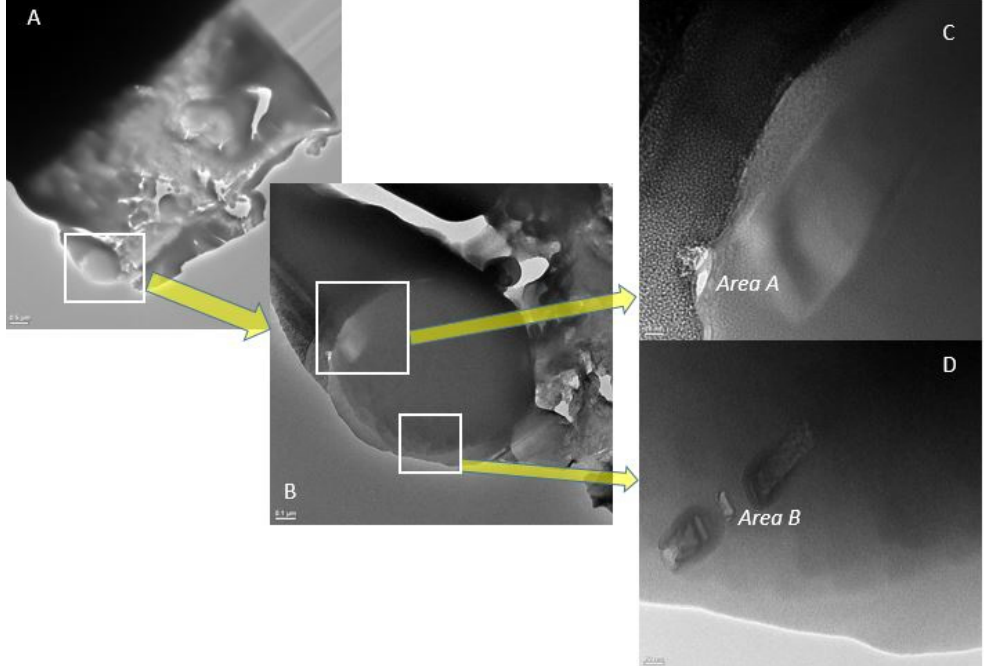
Figure 3. ( A ) Locations in the Al–Si glass sphere. ( B ) Area delimited by the white box in ( A ), with boxes showing the locations of area ( A ) and ( B ) (Figure 3 C , D , respectively).